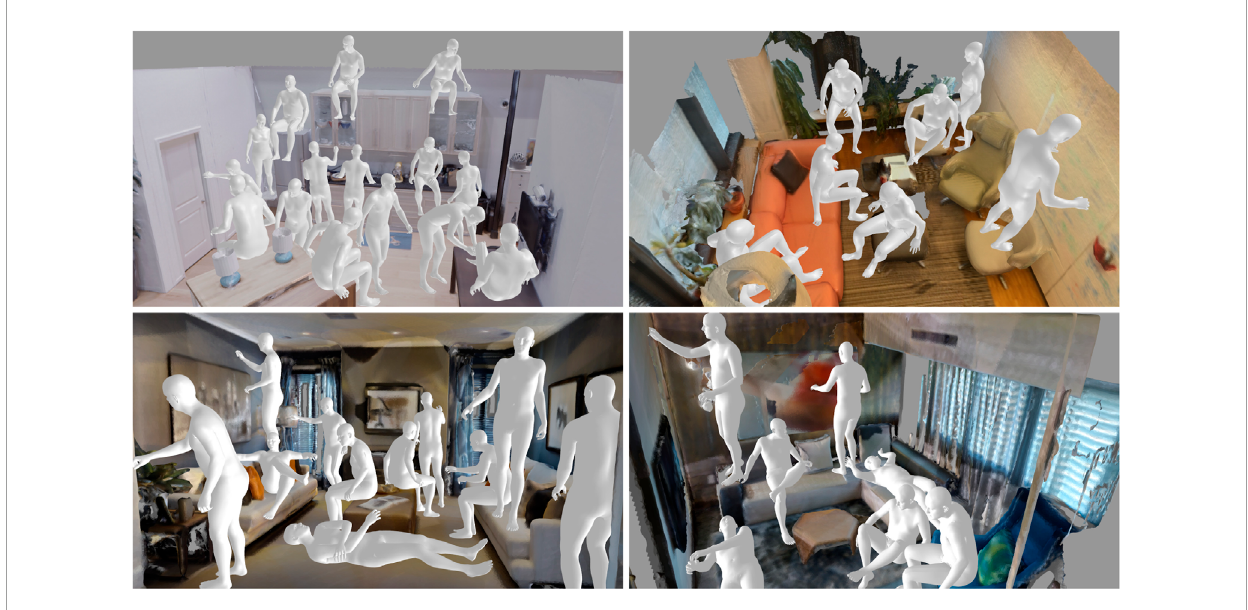
FIGURE 1 AROS is capable of detecting human–scene interactions with one-shot learning. Given a scene, our approach can detect locations that support interactions and generate the interacting human body in a natural and plausible way. Images show examples of detected sit-able, reach-able, lie-able, and stand-able